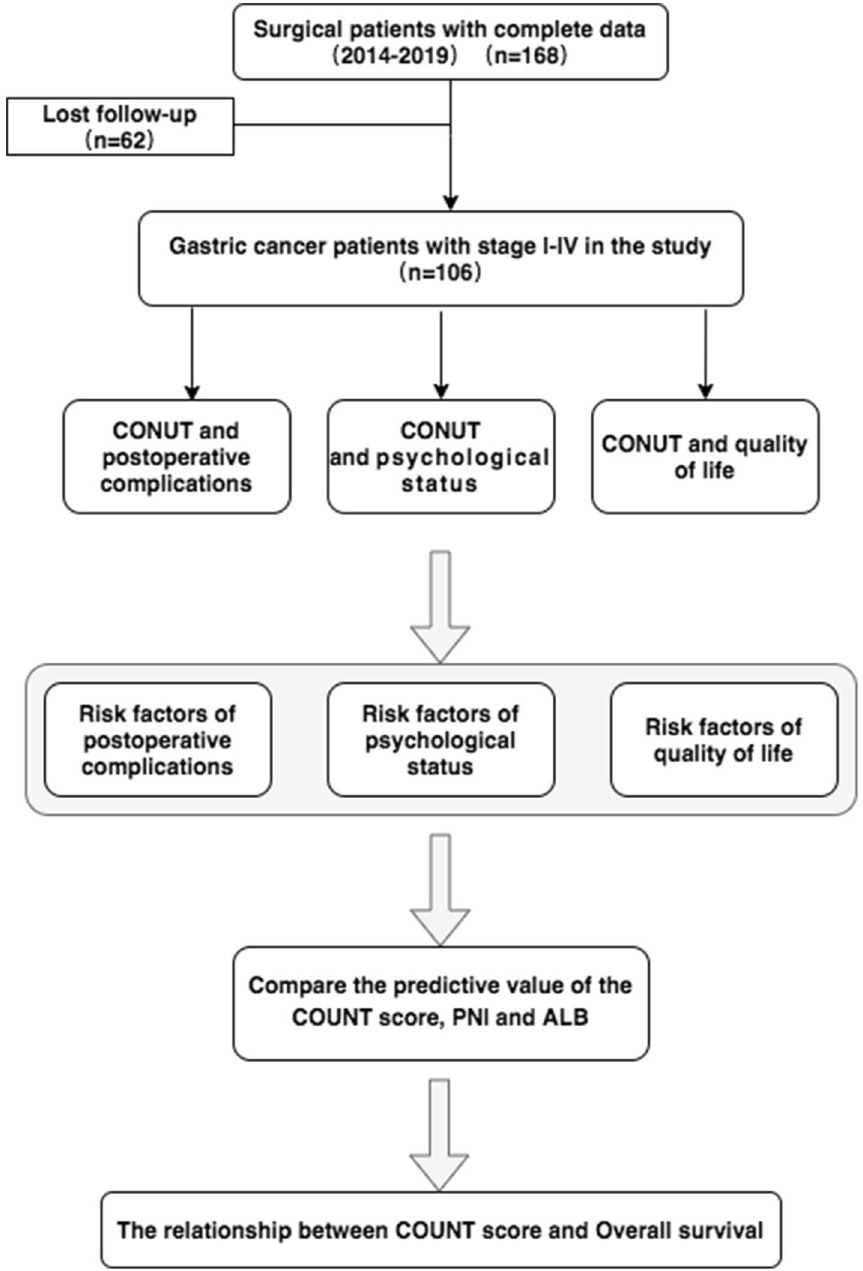
Figure 1. Flow chart of utilizing the value of CONUT score in the study of complications, psychological status, and QoL in gastric cancer